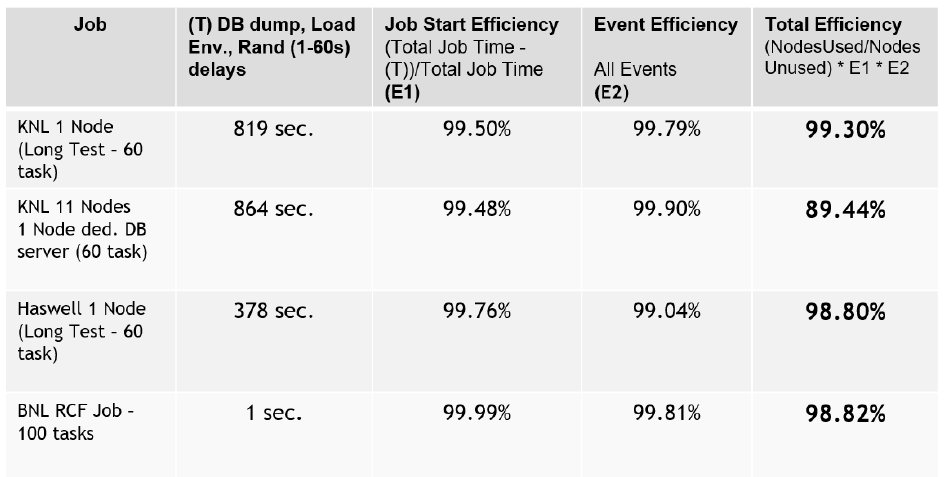
Figure 5. A table showing a breakdown of each efficiency as a percentage when running on KNL, KNL with a dedicated DB head node, a Haswell node, and the BNL